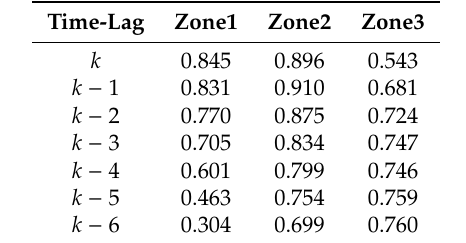
Table 3. The correlation coe ffi cient between GWL of three zones and SIA,